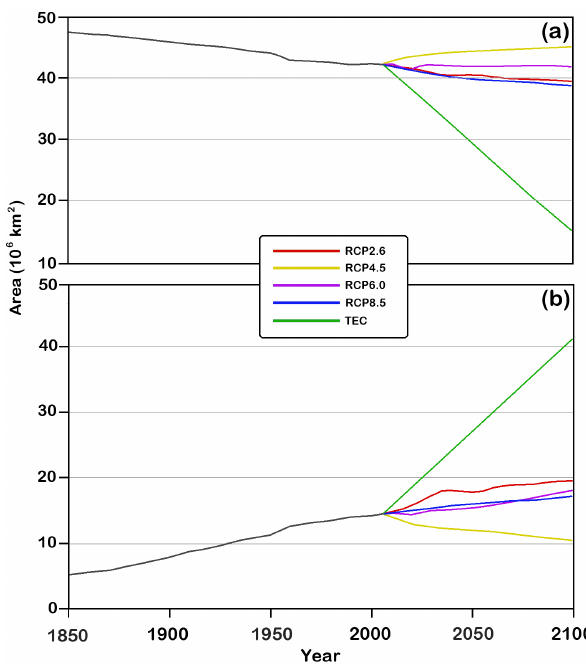
Figure A1. Change in global total (a) forest and (b) crop areal coverage with time for historical and Representative Concentration Pathway scenarios (Lawrence et al., 2012) and the theoretical ex- treme case (TEC,